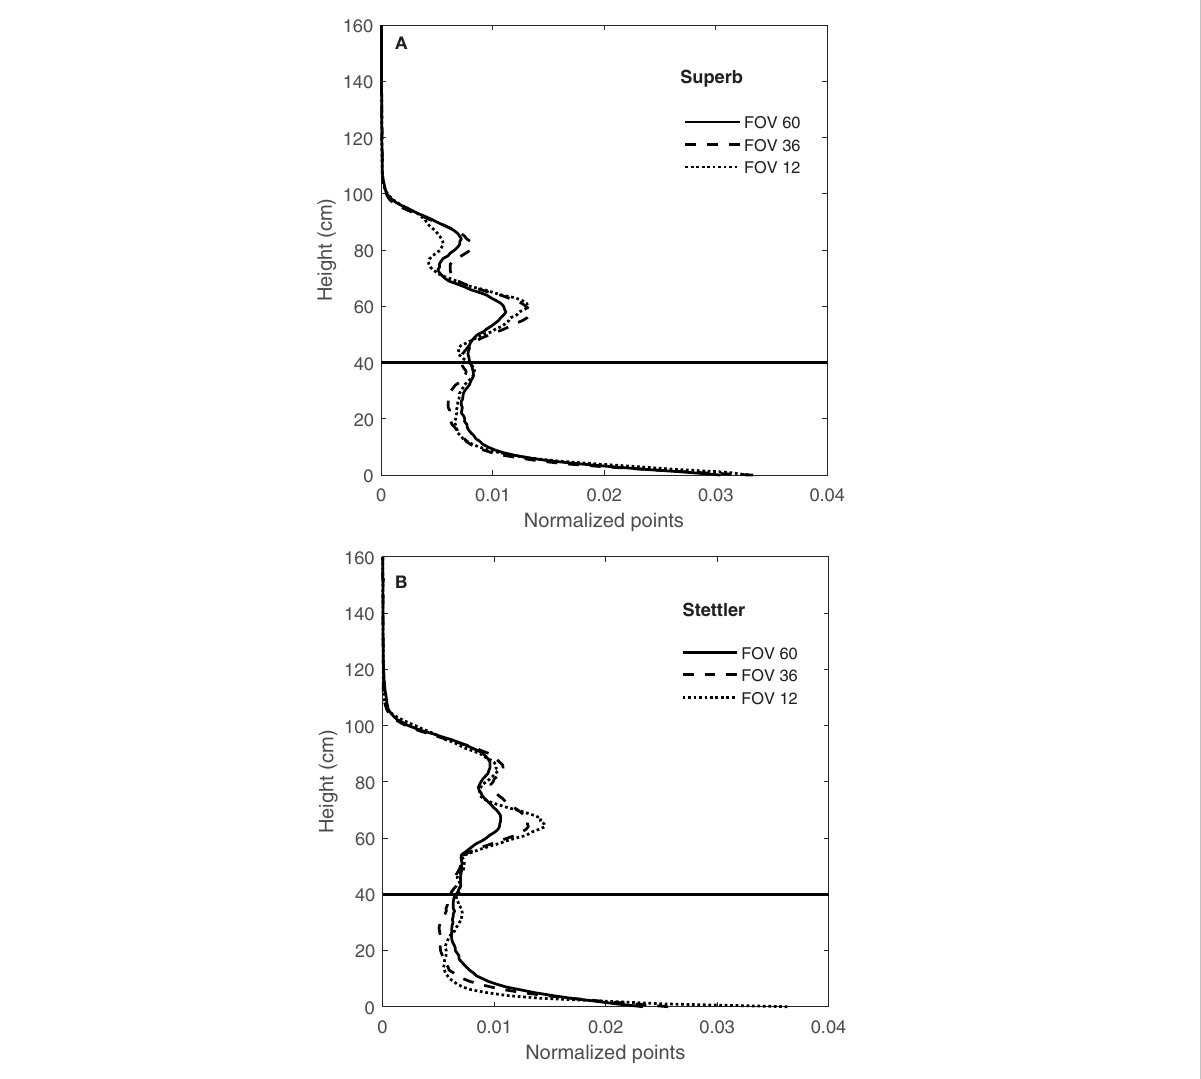
FIGURE 10 CVPs for FOV of 12, 36 and 60° for wheat genotype Superb (A) and for the wheat genotype of Stettler (B) on 15/08/2019 and the difference in the proportion of areas for FOV 12 and 60° for height greater than 40